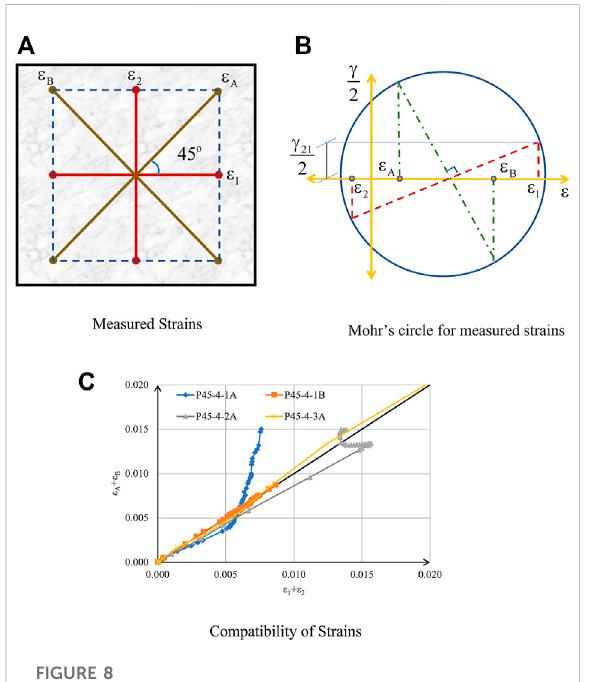
FIGURE 8 Mohr ’ s Compatibility check. (A) Measured Strains (B) Mohr ’ s circle for measured strains (C) Compatibility of Strains.